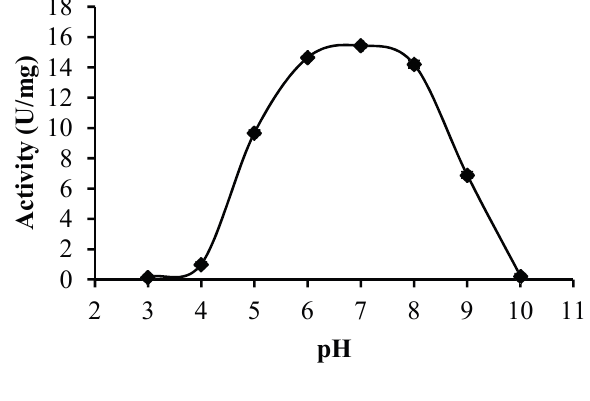
Figure 4. Effect of pH on activity of Bentong ginger